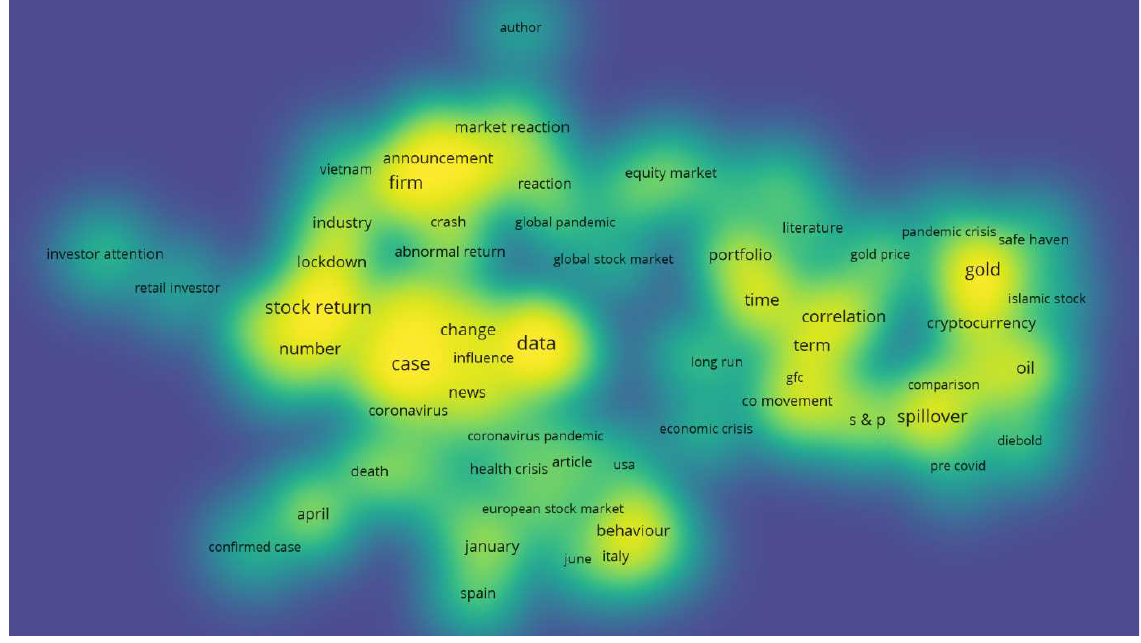
Figure 5. Density visualization on the Scopus